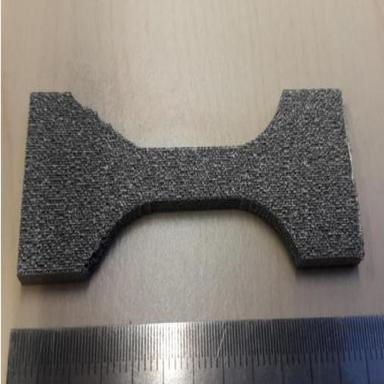
Inconel⃝R